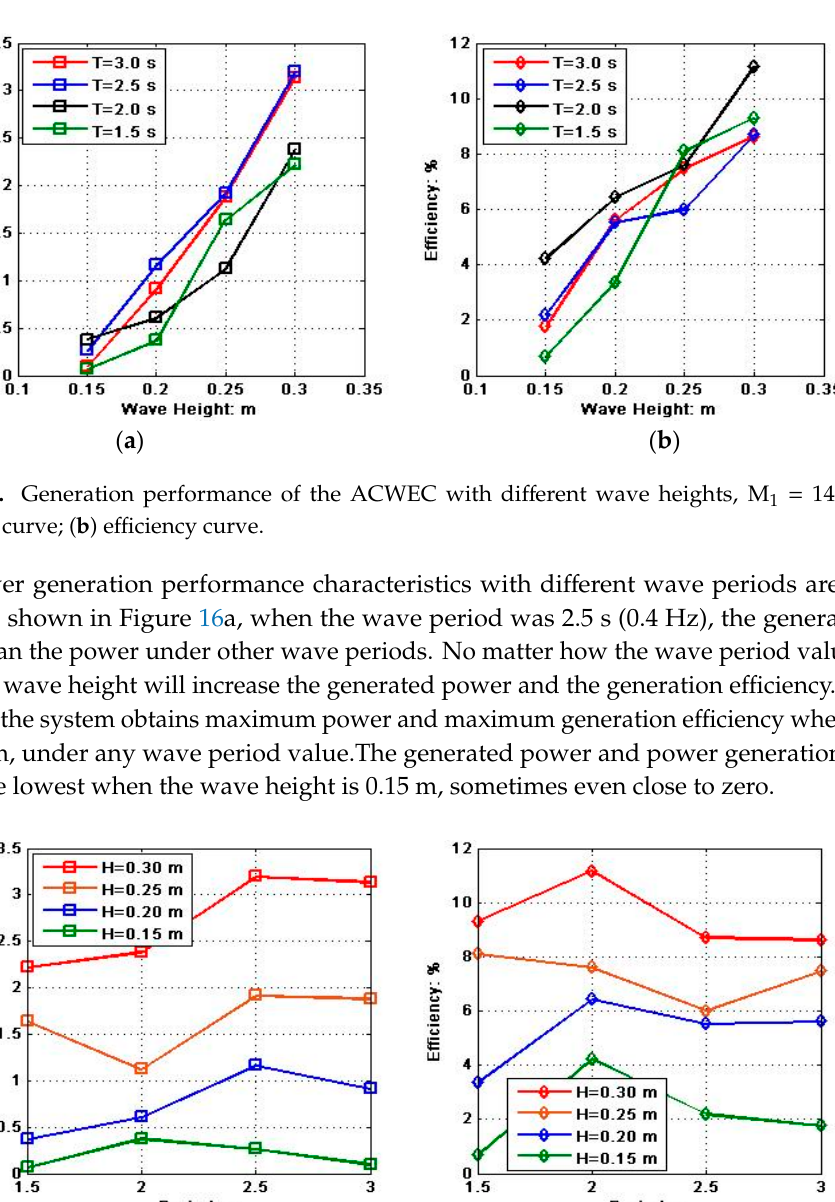
Figure 16. Generation performance of the ACWEC with different wave periods, M 1 = 14.21 kg: ( a ) power curve; ( b ) efficiency curve. ( a ) power curve; ( b ) e ffi ciency